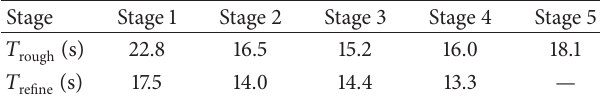
Table 11: Computation time in each stage (Case